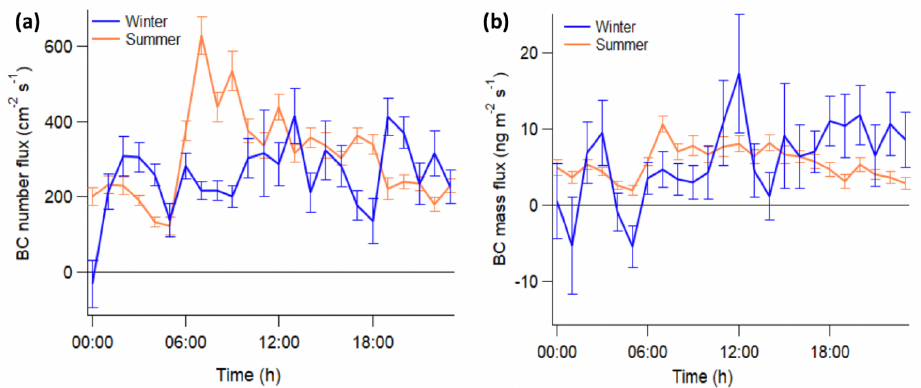
Figure 8. Diurnal cycles for (a) number and (b) mass flux in summer and winter with error bars (standard errors, from the calculated precision). For this analysis, storage-corrected fluxes are used to help understand ground-based